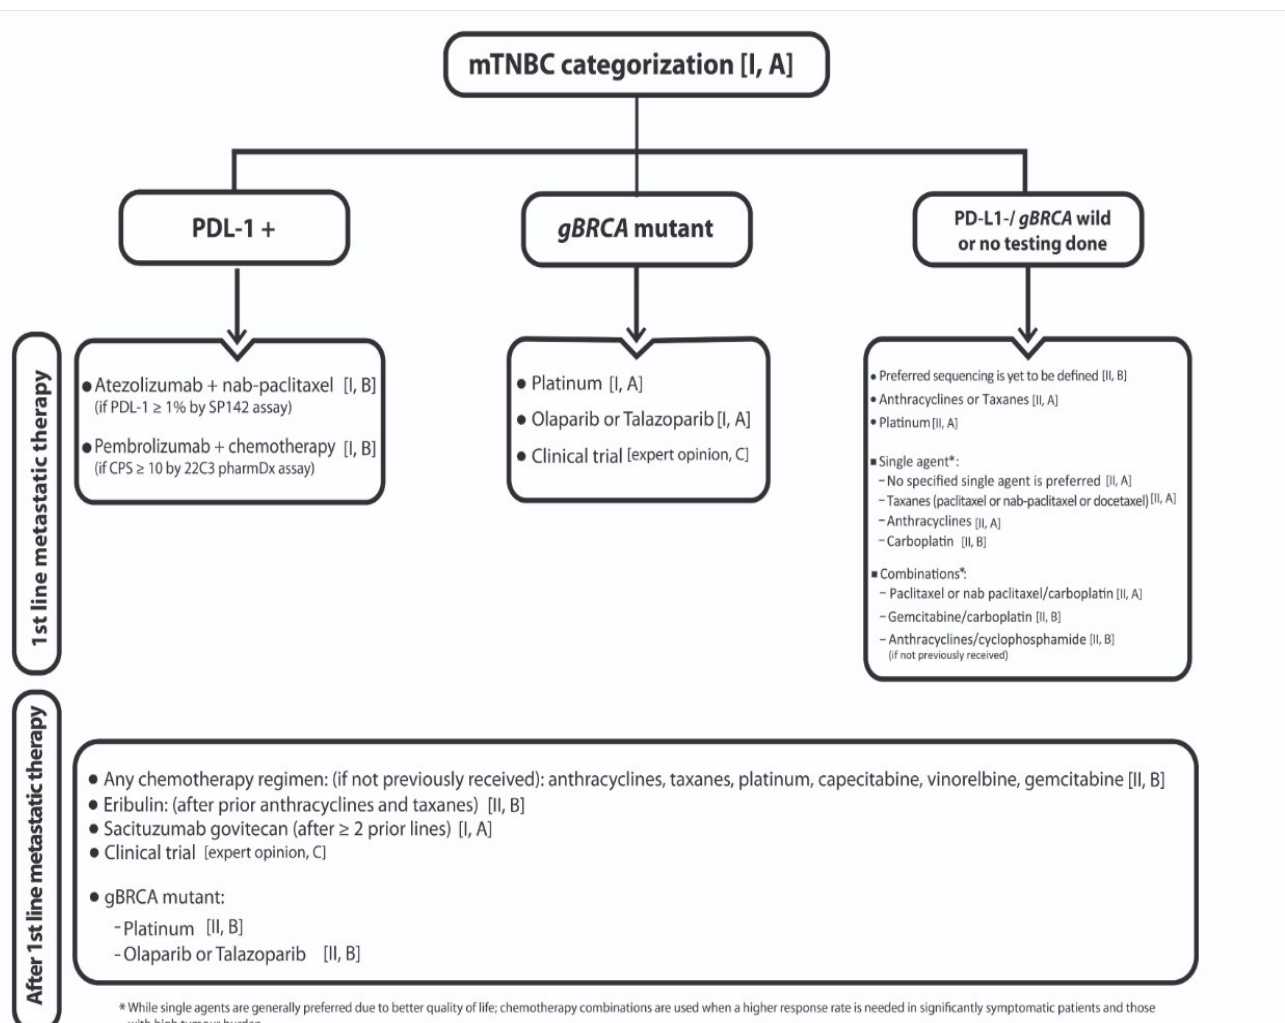
Figure 2. The treatment algorithm for metastatic TNBC according to subtype.